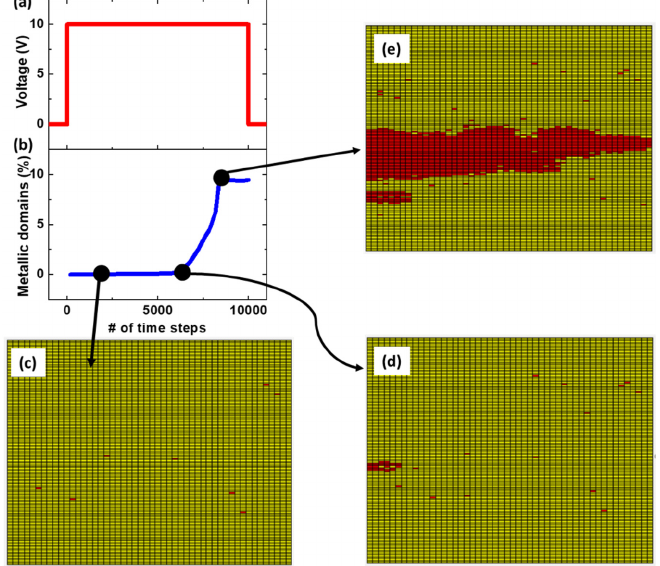
Figure 5. ( a ) The applied single voltage used in the simulation. ( b ) The percentage of metallic domain changes with the simulation steps (time elapsed after the bias is applied). ( c – e ) The distribution of the metallic domains at the different stage after voltage bias is applied (yellow: insulating domains; red: metallic domains). In these simulations, we used a resistance network comprising of 150 × 50 pixels. All